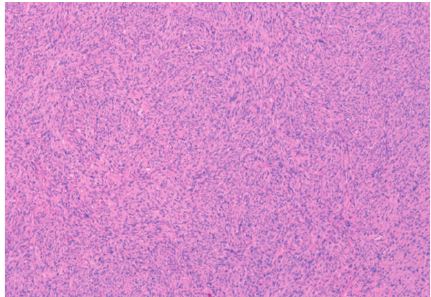
Figure 3: Tumour cells with diffuse positive staining for